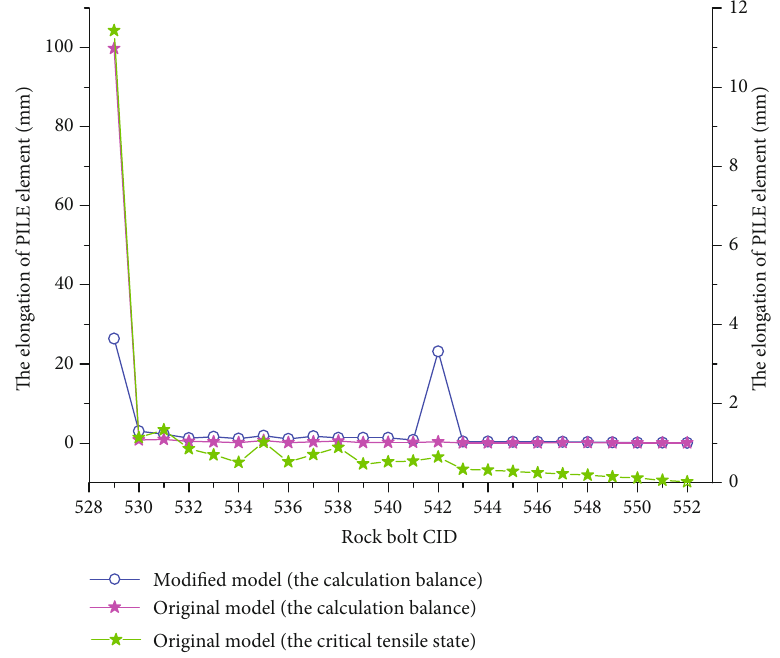
Figure 18: The elongation distribution of rock bolt No. 8 under di ff erent states.